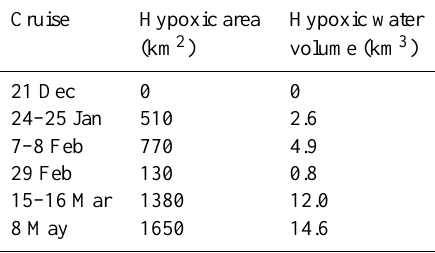
Table 1. Estimated hypoxic bottom areas and hypoxic water vol- umes. On 8 May hypoxic values were calculated on the basis of bottom oxygen concentrations and salinity profiles: linear regres- sion between sea areas and volumes occupied by hypoxic water and by water with salinity ≥ 9.3gkg − 1 was used in estimation. Area under consideration (approximately 10000km 2 ) was between the western border of the Gulf of Finland and the easternmost station, A10 (Fig.